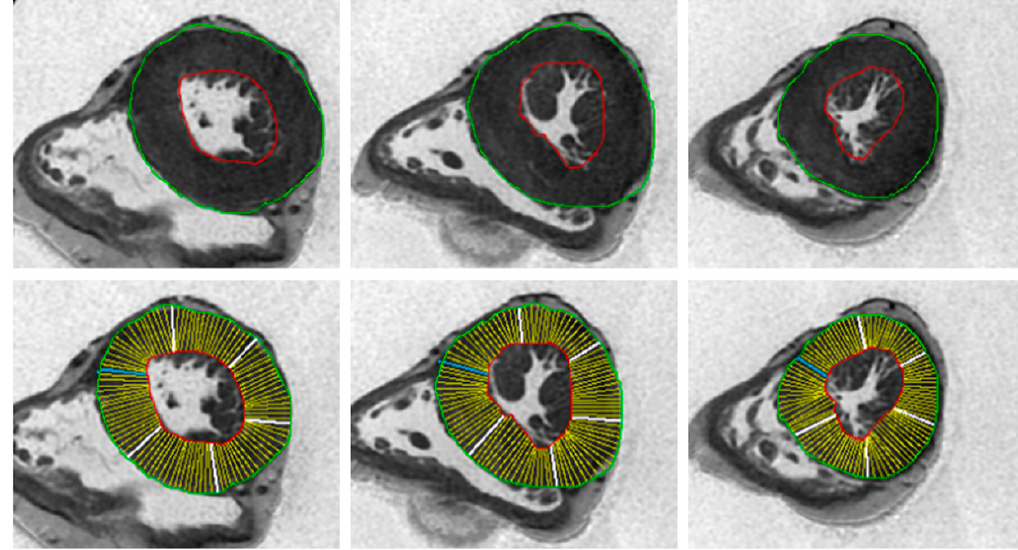
Figure 2. Example of analysis of post-mortem cardiac magnetic resonance images. In these images, the endocardial and epicardial contours were traced, and the myocardial thickness of all of the 17 myocardial segments was measured. The same parameters of Figure 1 were